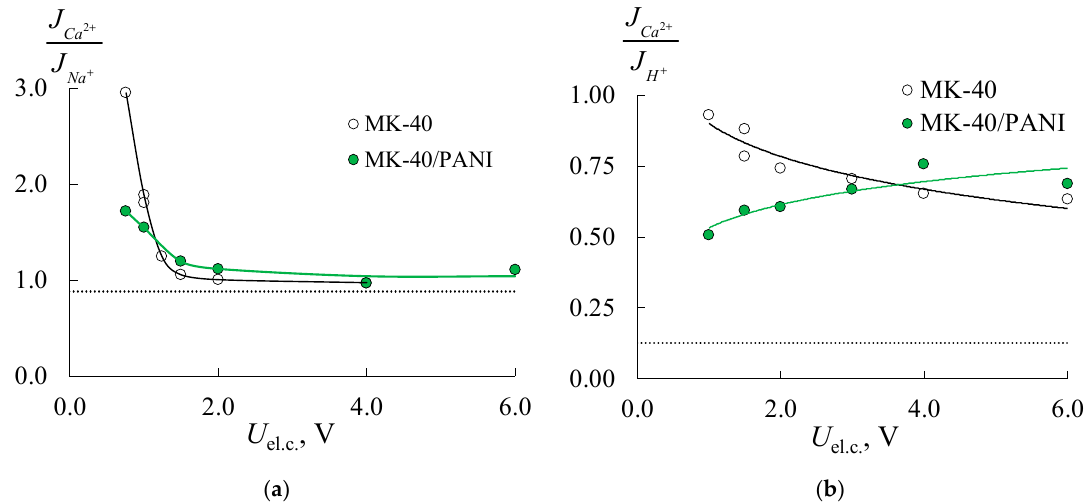
Figure 11. Theoretical (dashed line) and experimental (points and solid lines) dependencies of Ca 2+ /Na + ( a ) and Ca 2+ /H + ( b ) flux ratios for the initial MK-40 and composite MK-40/PANI membranes.